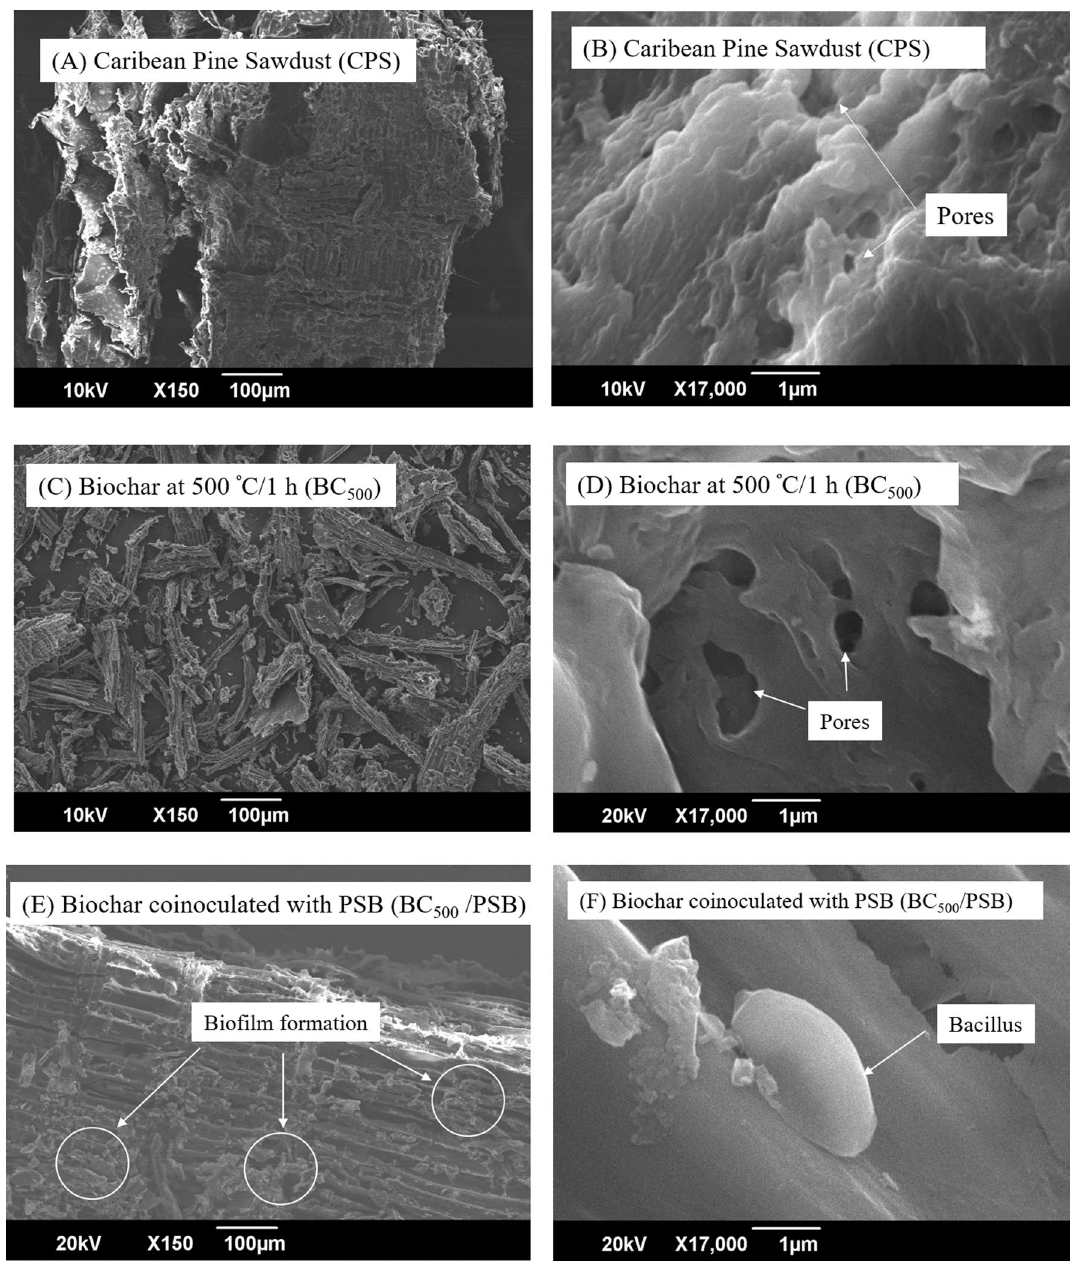
Figure 2. Morphological characteristics of the material. ( A ) Caribean Pine Sawdust (CPS) at SEM 150x. ( B ) Caribean Pine Sawdust (CPS) at SEM 17000x. ( C ) Biochar (BC 500 ) at 500 °C/1 h, SEM 150x ( D ) Biochar (BC 500 ) at 500 °C/1 h, SEM 17000x. ( E ) Biochar co-inoculated with PSB (BC 500 /PSB), SEM 150x. ( F ) Biochar co-inoculated with PSB (BC 500 /PSB), SEM